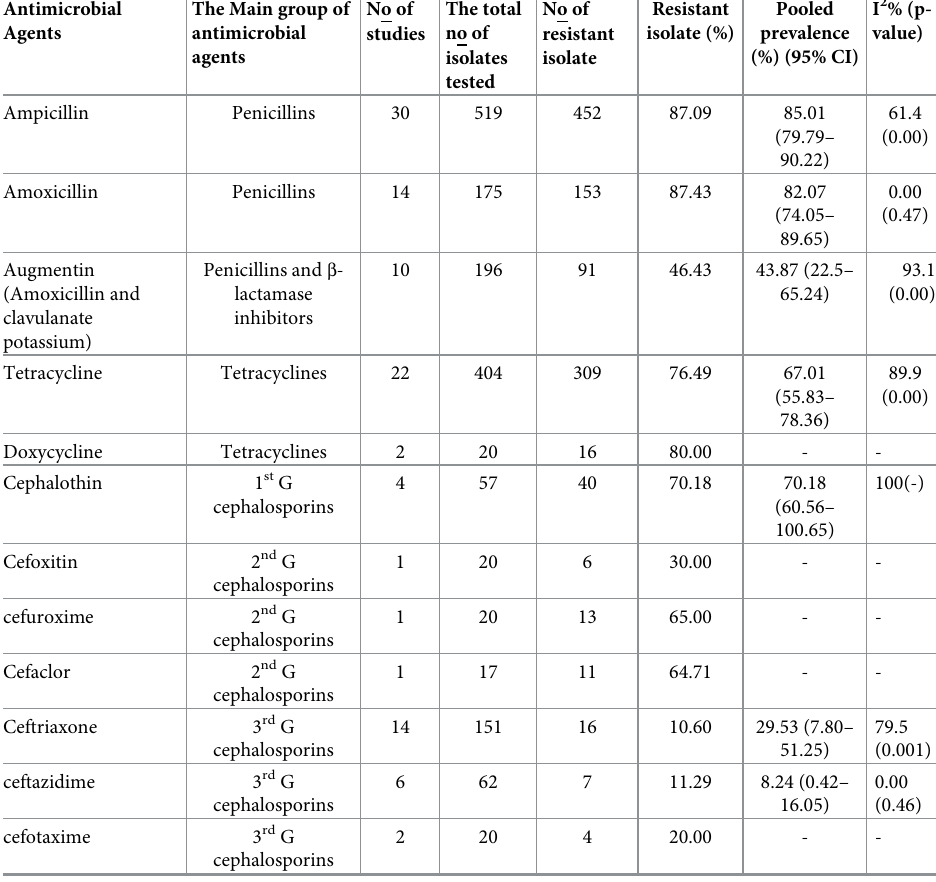
Table 5. Prevalence of Shigella spp. resistance to different antimicrobial agents in Ethiopia. Antimicrobial